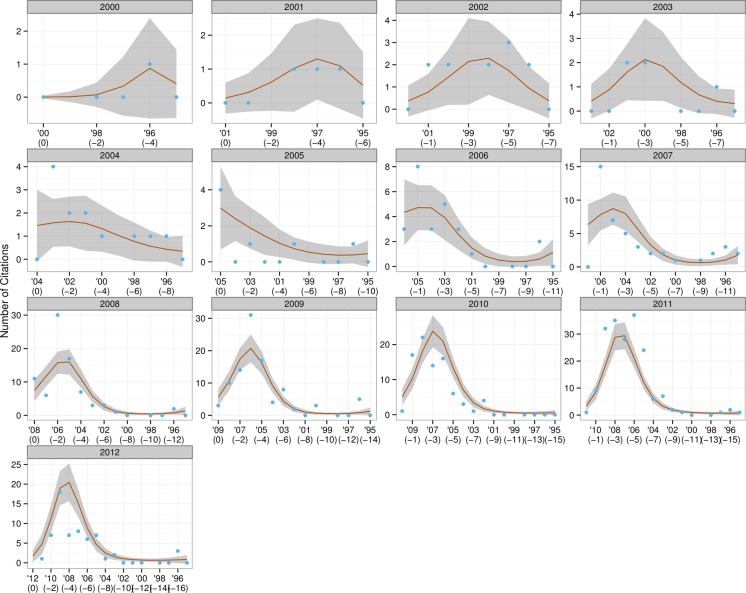
Trends in citations for MA theses.